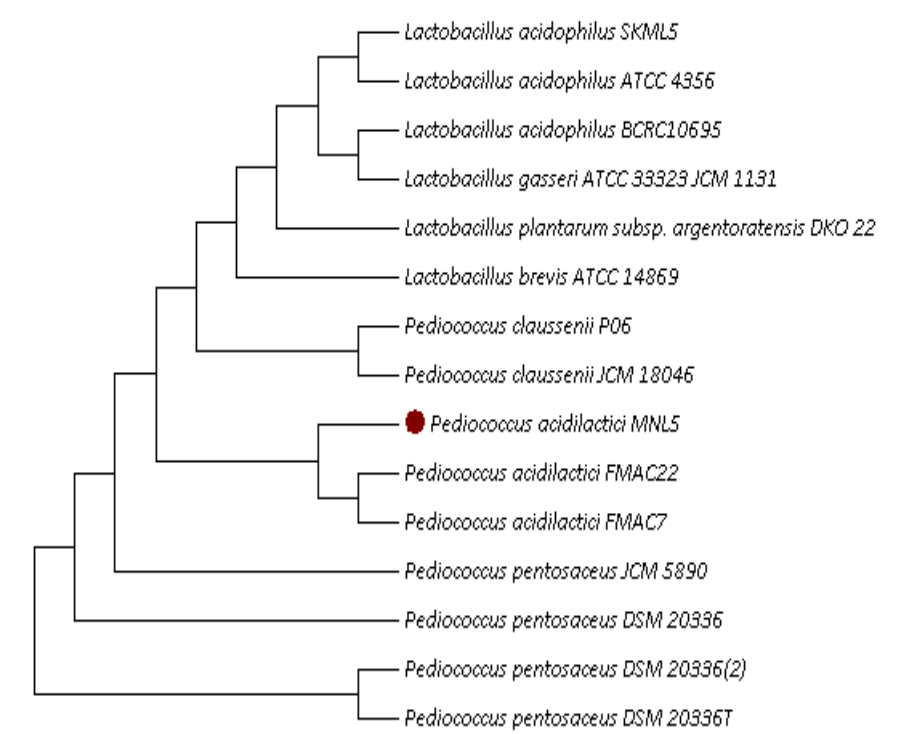
Figure 2. The 16S rRNA sequence of Pediococcus acidilacticii MNL5 based phylogenetic tree was constructed by the neighbor-joining method. The numbers at the nodes are bootstrap values based on 0.0001 replications.